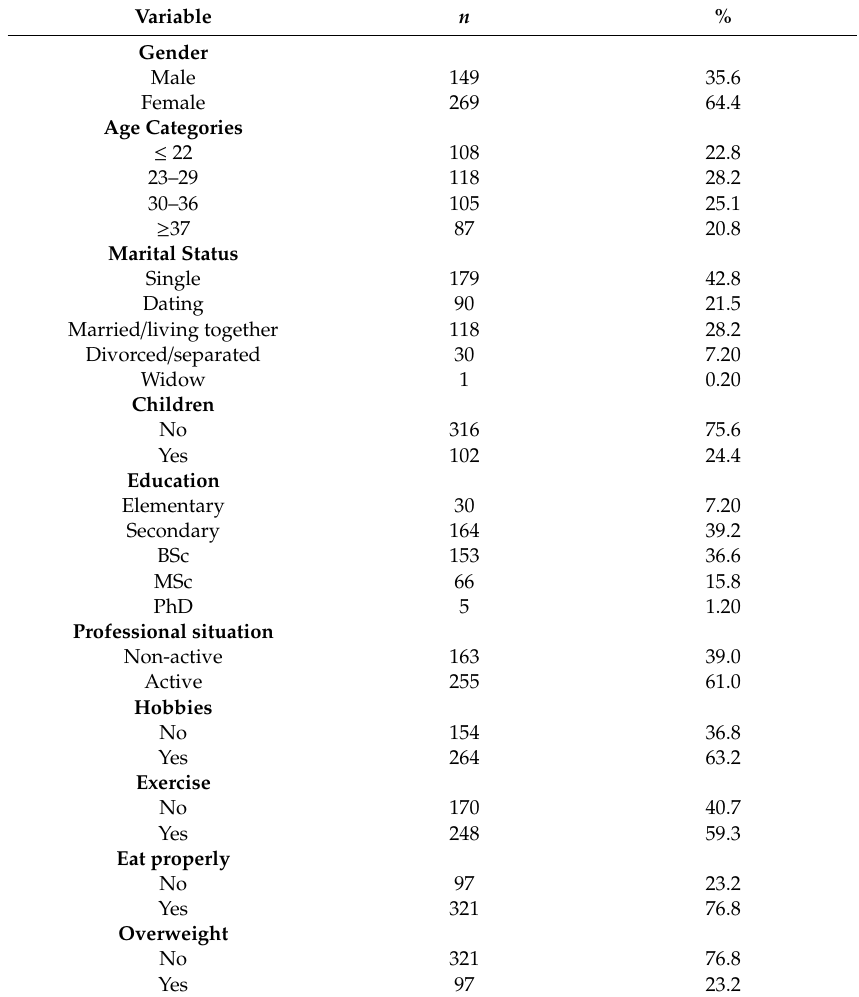
Table 1. Profile of the respondents.